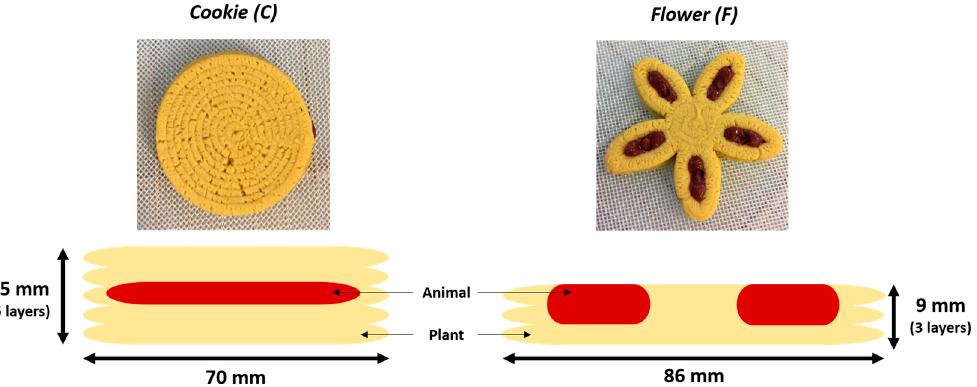
Figure 2. Detailed view of the 3D-printed food geometries and schematic distribution of animal- source (in red) and plant-source (in yellow) mixtures.